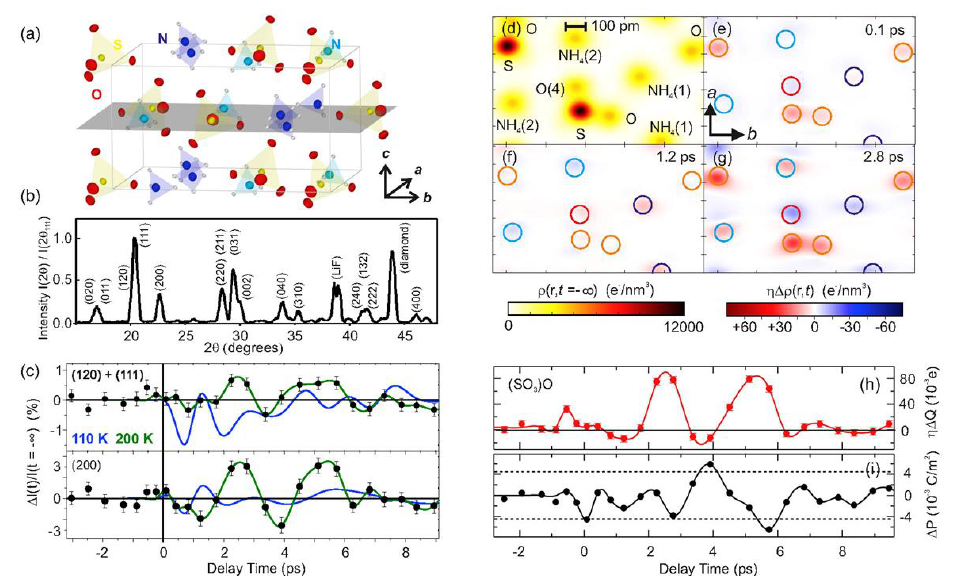
Fig 1. (a) Equilibrium crystal structure of ferroelectric ammonium sulfate (AS). The grey area marks the lattice plane for which electron densities are plotted in panels (d-g). (b) Lineout of the equilibrium powder diffraction pattern of ferroelectric AS at 200 K. The x-ray intensity integrated over a particular Debye Scherrer ring is plotted as a function of the diffraction angle 2  . (c) Transient changes of diffracted x-ray intensity for two reflections upon femtosecond excitation of ferroelectric AS at temperatures of 200 K (symbols, green lines) and 110 K (blue lines), the latter displaying a different time evolution. (d) Equilibrium electron density  ( r ,t=-  ) in the lattice plane marked in panel (a). The lettering gives the different molecular subunits. (e-g) Transient charge density maps  ( r ,t) for different pump-probe delays (  0.06: fraction of excited unit cells). (h) Spatially integrated change of total charge  Q(t) on the SO 3 subunits in the crystal structure as a function of pump-probe delay. (i) Change of macroscopic electric polarization  P as a function of pump-probe delay (dashed lines: amplitude of the stationary electric polarization of ferroelectric